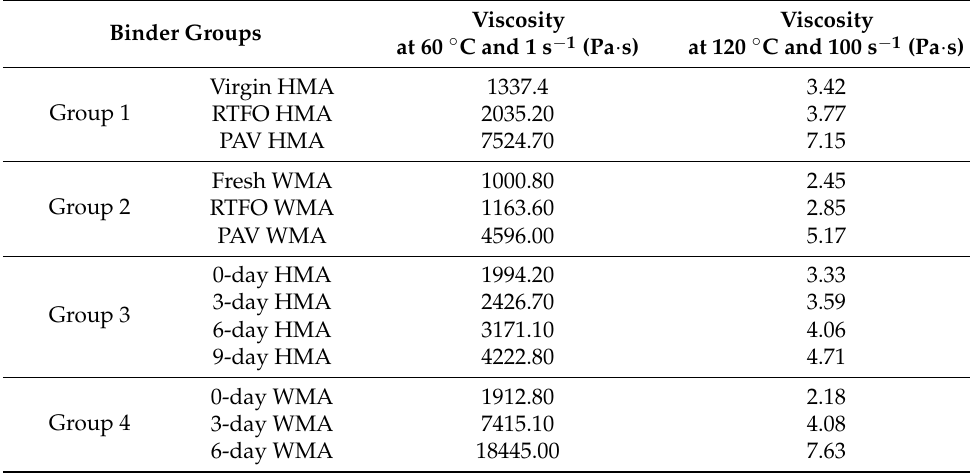
Table 3. Viscosity of all binders at 60 °C and 120 °C.